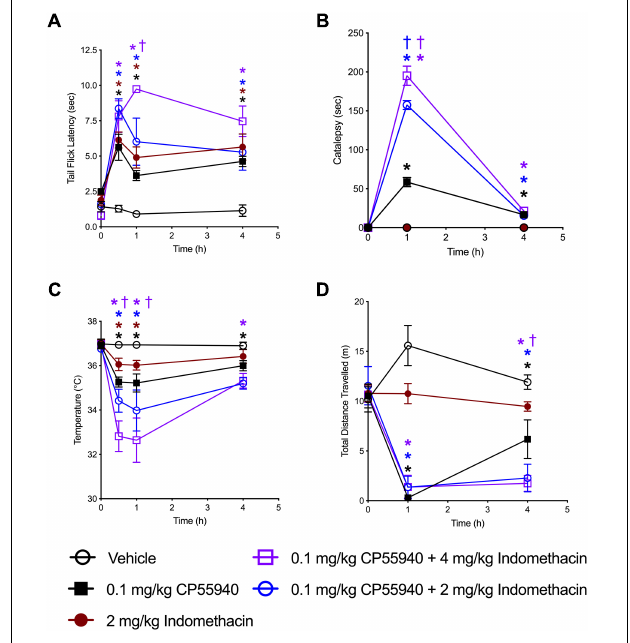
FIGURE 6 | Indomethacin enhanced CP55940-dependent tetrad effects. Seven-week old, male, C57BL/6 mice were injected ( i.p. ) with vehicle, CP55940 (0.1 mg/kg), indomethacin (2 mg/kg), CP55940 (0.1 mg/kg) + indomethacin (2 mg/kg), or CP55940 (0.1 mg/kg) + indomethacin (4 mg/kg) and tetrad tests were completed as follows: tail flick latency at 0 (prior to treatment), 0.5, 1, and 4 h after injection (A) , catalepsy at 0, 1, and 4 h after injection (B) , internal body temperature at 0, 0.5, 1, and 4 h after injection (C) , total distance traveled in the open field at 0, 1, and 4 h after injection (D) . ∗ P < 0.01 compared to vehicle within time point, † P < 0.01 compared to CP55940 alone within timepoint, as determined via two-way ANOVA followed by Bonferroni’s post hoc analysis. Data are mean ± SEM. N = 5 per treatment group.